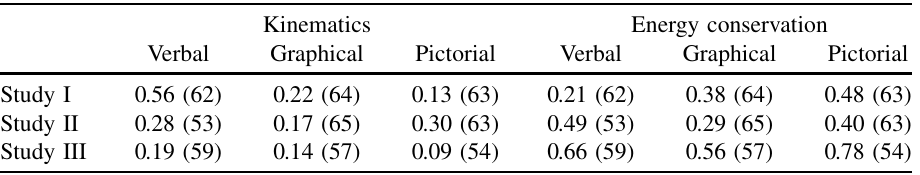
TABLE II. Fraction of answers with justification based on kinematics and conservation of energy in different representational